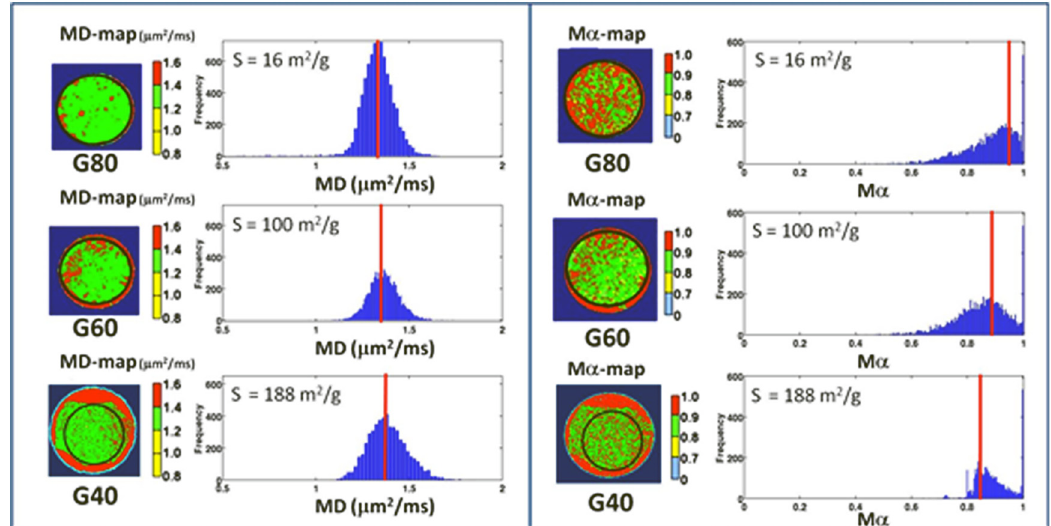
Figure 3. ( Left ): Conventional diffusion MRI based on Brownian diffusion. MD-maps obtained at diffusion time t = ∆ = 100 ms, for the three polymeric matrices samples (G80, G60, G40), together with the measured distribution of MD values in the ROI bordered by the black circles, are reported. Red straight lines indicate the median = mean value. ( Right ): Anomalous diffusion MRI. M α -maps obtained for G80, G60 and G40 samples, together with the measured distribution of M α values in the ROI bordered by the black circles. Red straight lines indicate the median value. The results displayed here suggest that MD is not sensible to sub-microstructure variations. Conversely, M α discriminates among polymeric matrices characterized by different specific surface areas S (m 2